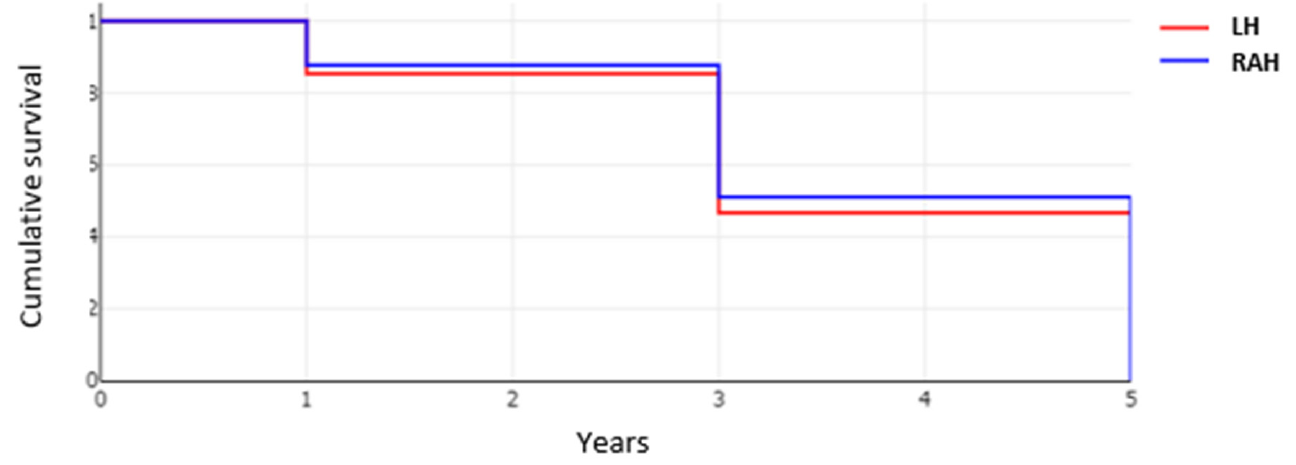
Figure 7. Cumulative survival for LH and RAH approaches.